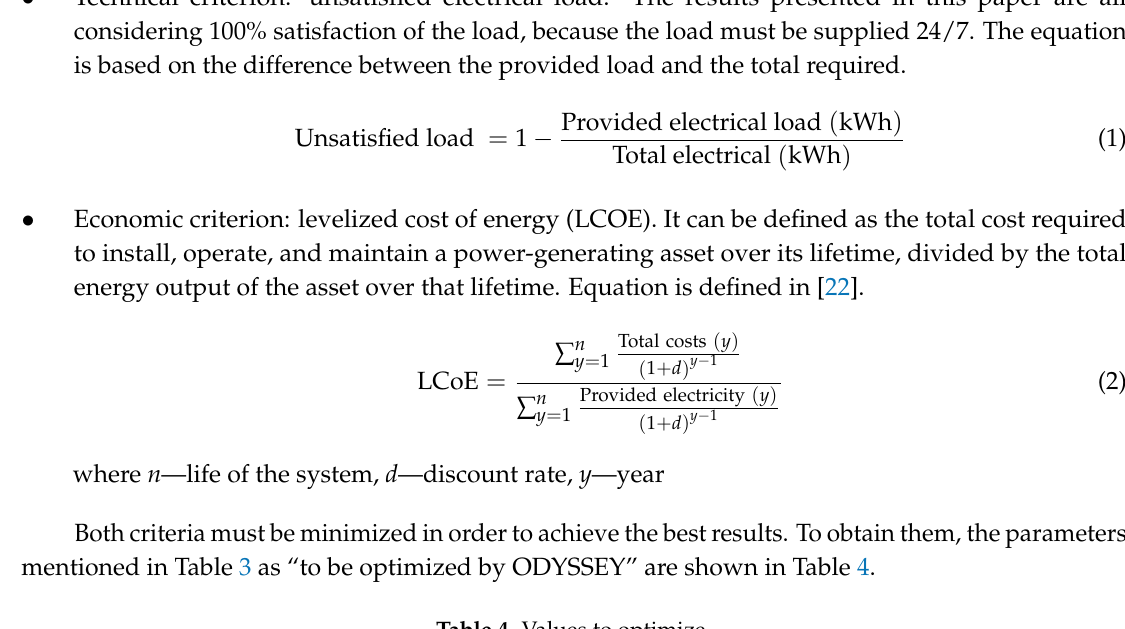
Table 4. Values to optimize.